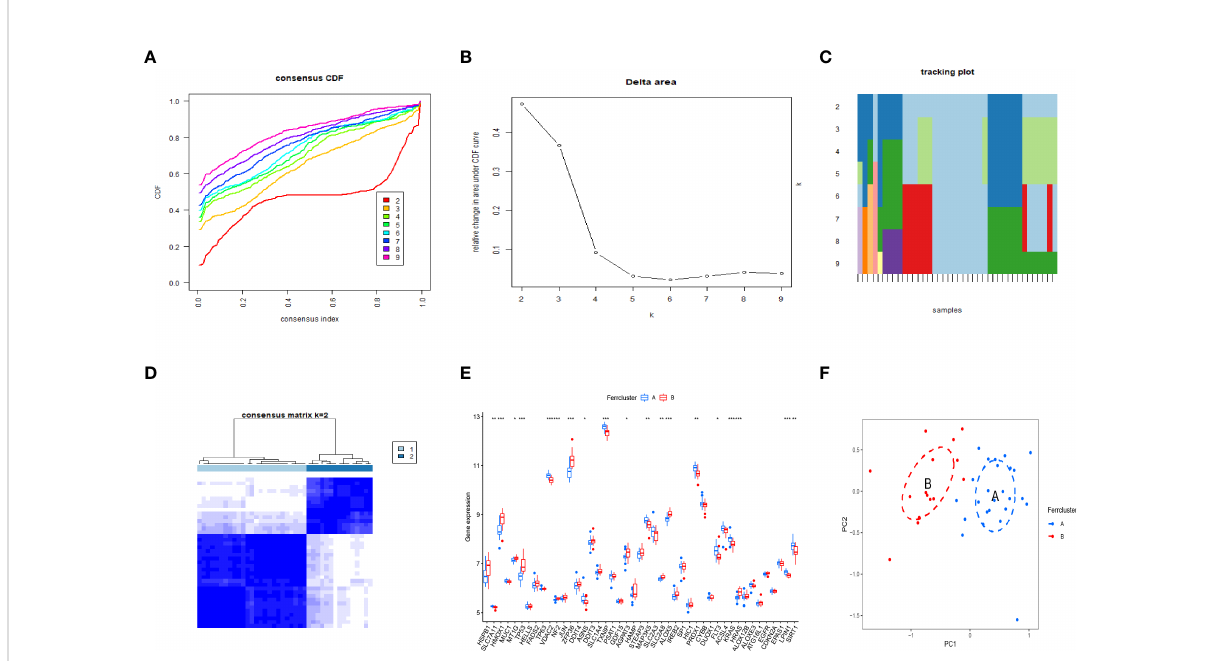
FIGURE 4 Two OP subgroups obtained by consensus clustering. (A) Curve of the CDF when k=2-9. (B) The delta area score of the CDF curve when k= 2 – 9. (C) Tracking plot when k =2 – 9. (D) The matrix heat map was neatly categorized when k=2. (E) The expression of 45 DEFAGs between ferrcluster A and ferrcluster B is shown in the histogram. (F) PCA based on the expression of the 45 DEFAGs can distinguish OP patients in ferrcluster A and ferrcluster B. *P < 0.05; **P < 0.01; ***P < 0.001.